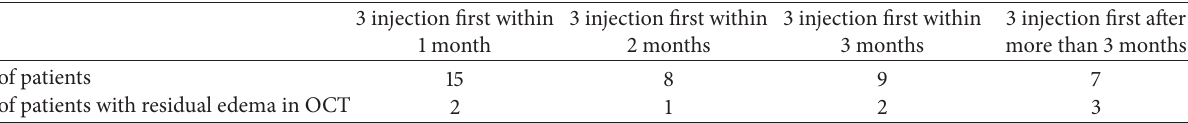
Table 4: Patients, timing of injections, and residual edema in OCT-3 injections group.